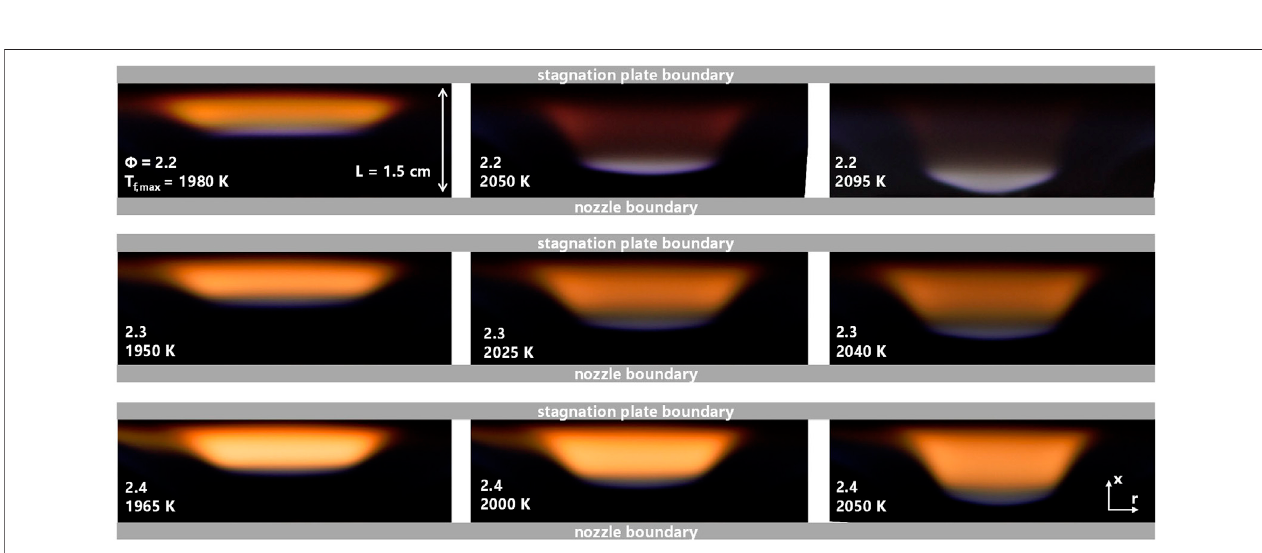
Figure 2 . The image is a projection of the axisymmetric